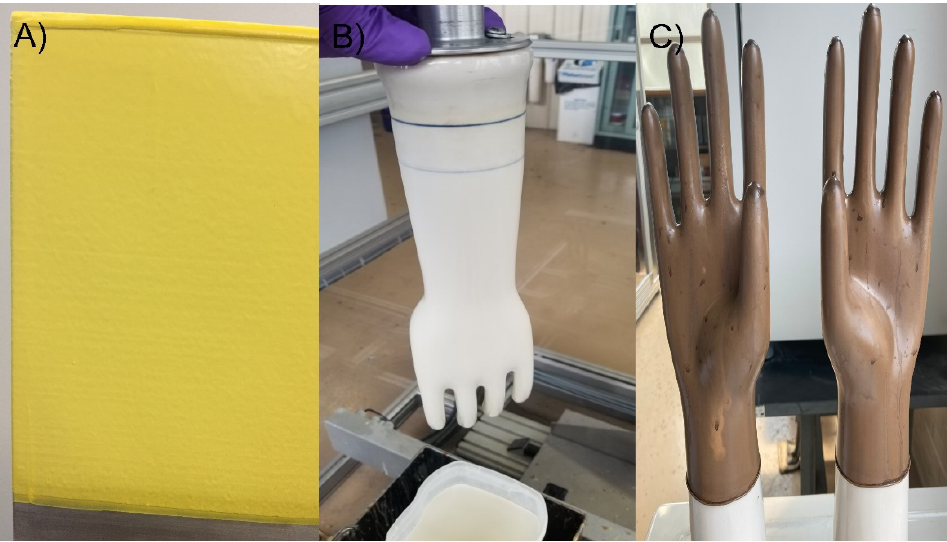
Figure 2. Films and RA gloves preparation. ( A ) Pre-curing of GNRL/micro-Bi 2 O 3 film prepared by dipping; ( B ) Preparation of glove former before dipping into GNRL/micro-Bi 2 O 3 ; ( C ) Post-curing RA gloves.